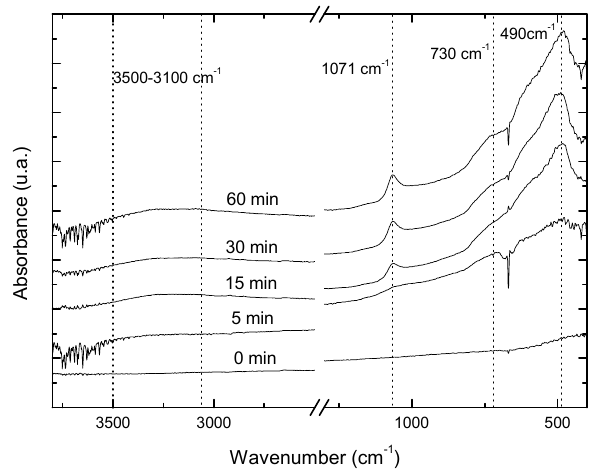
Figure 7. Fourier transform infrared spectroscopy (FTIR) of the film produced on aluminum immersed in water at 85° C as a function of time.